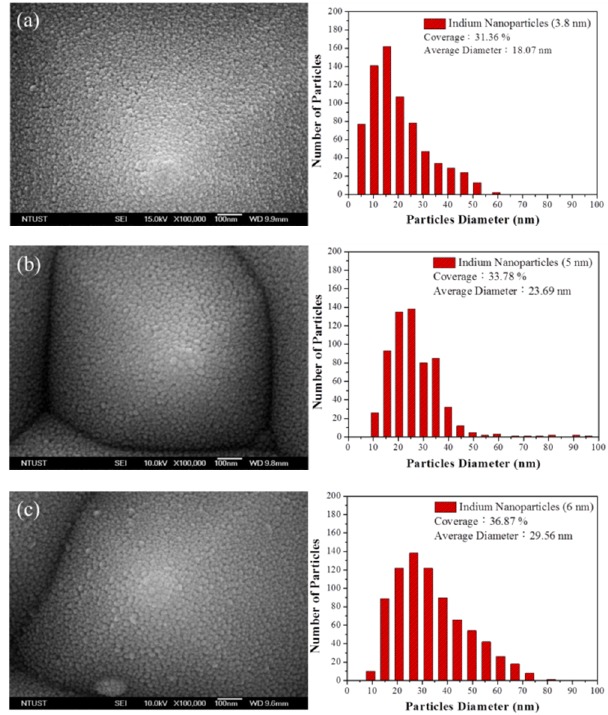
Figure 5. Top-view SEM images and particles profile of ( a ) 3.8 nm; ( b ) 5 nm; ( c ) 6 nm thick indium film deposited and annealed on the pyramidal surface structure of plasmonic textured C-Si solar cells.